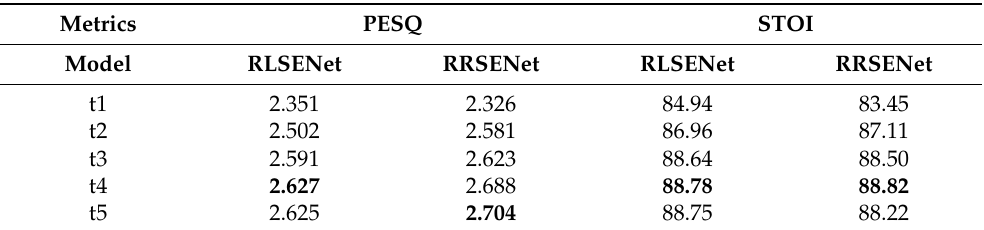
Table 5. Experimental results of RLSENet and RRSENet under seen noise conditions. BOLD indicates the best result for each